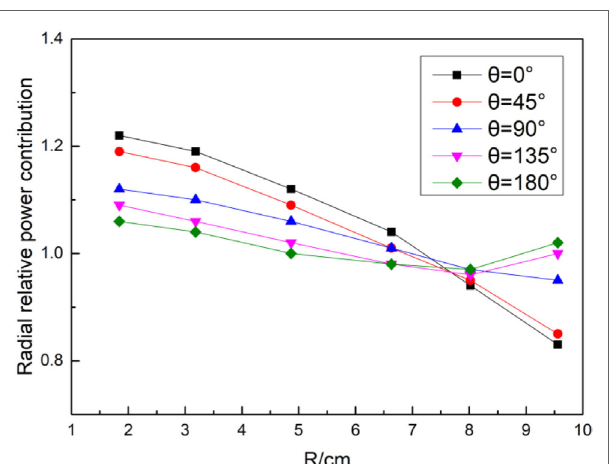
FigUre 8 | Reactivity varied with temperature.